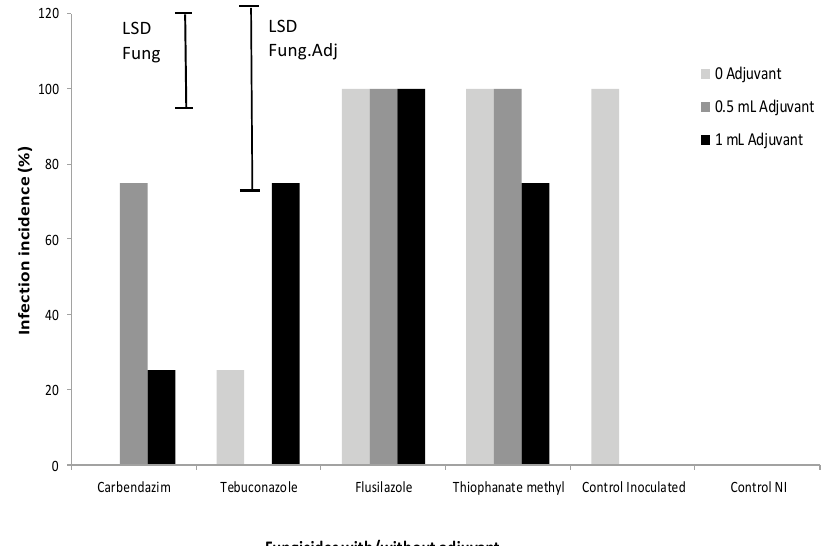
Figure 2. Effects of soaking grapevine canes superficially infected with Neofusicoccum luteum conidia in fungicide solutions, with or without a polyether-modified trisiloxane adjuvant (Engulf™), on incidence of the pathogen. Error bars are the 5% Fishers least significant differences (LSDs) for the fungicides (27.8%) and the fungicide.adjuvant interaction